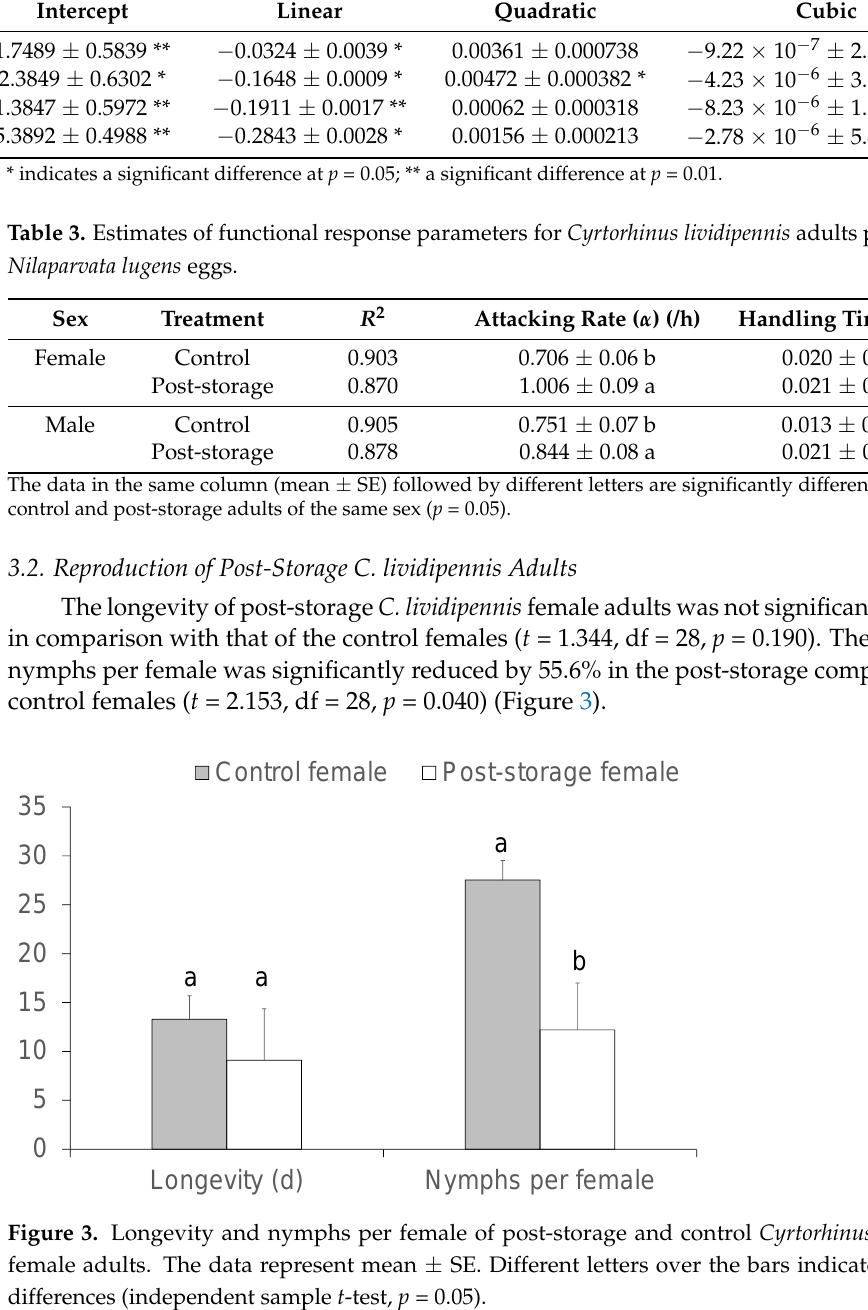
Table 2. Maximum likelihood estimates ( ± SE) from logistic regressions of the proportion of preys consumed in relation to initial prey density by Cyrtorhinus lividipennis females and males exposed to LTS or not.